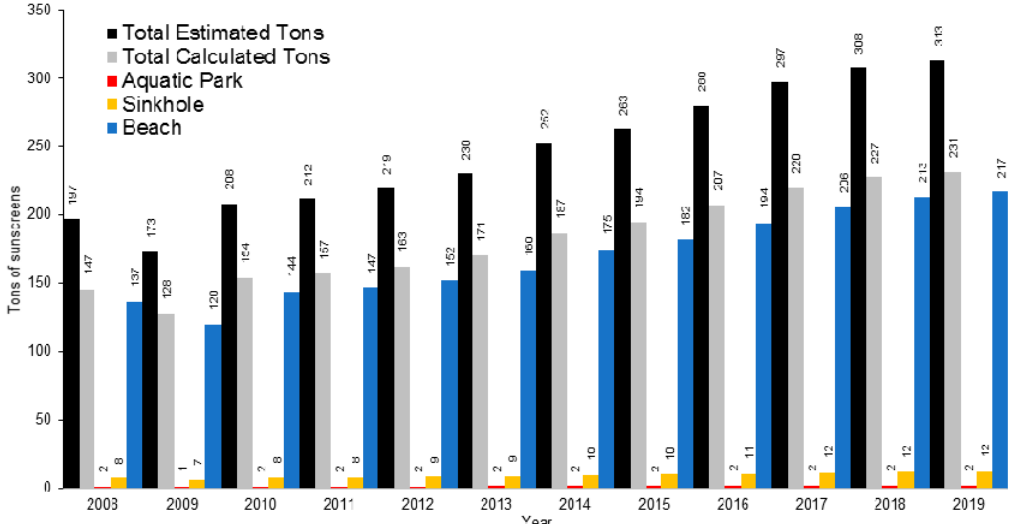
Figure 1. Estimated total sunscreen discharge by Casas-Beltran [1] and the present study for the last 12 years of tourist activity in the state of Quintana Roo, M é xico. To determine total calculated tons (TCT), we used field-generated survey data to adjust the total estimated tons. TCT is broken down by study area: aquatic parks, sinkholes, and